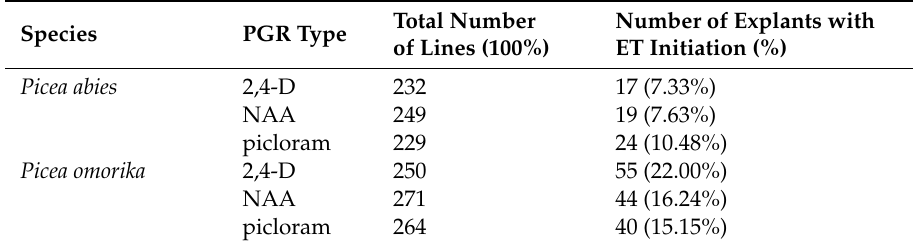
Table 1. Embryogenic tissue initiation from mature zygotic embryos in Picea abies (L.) H. Karst and P. omorika (Panˇci´c) Purk.